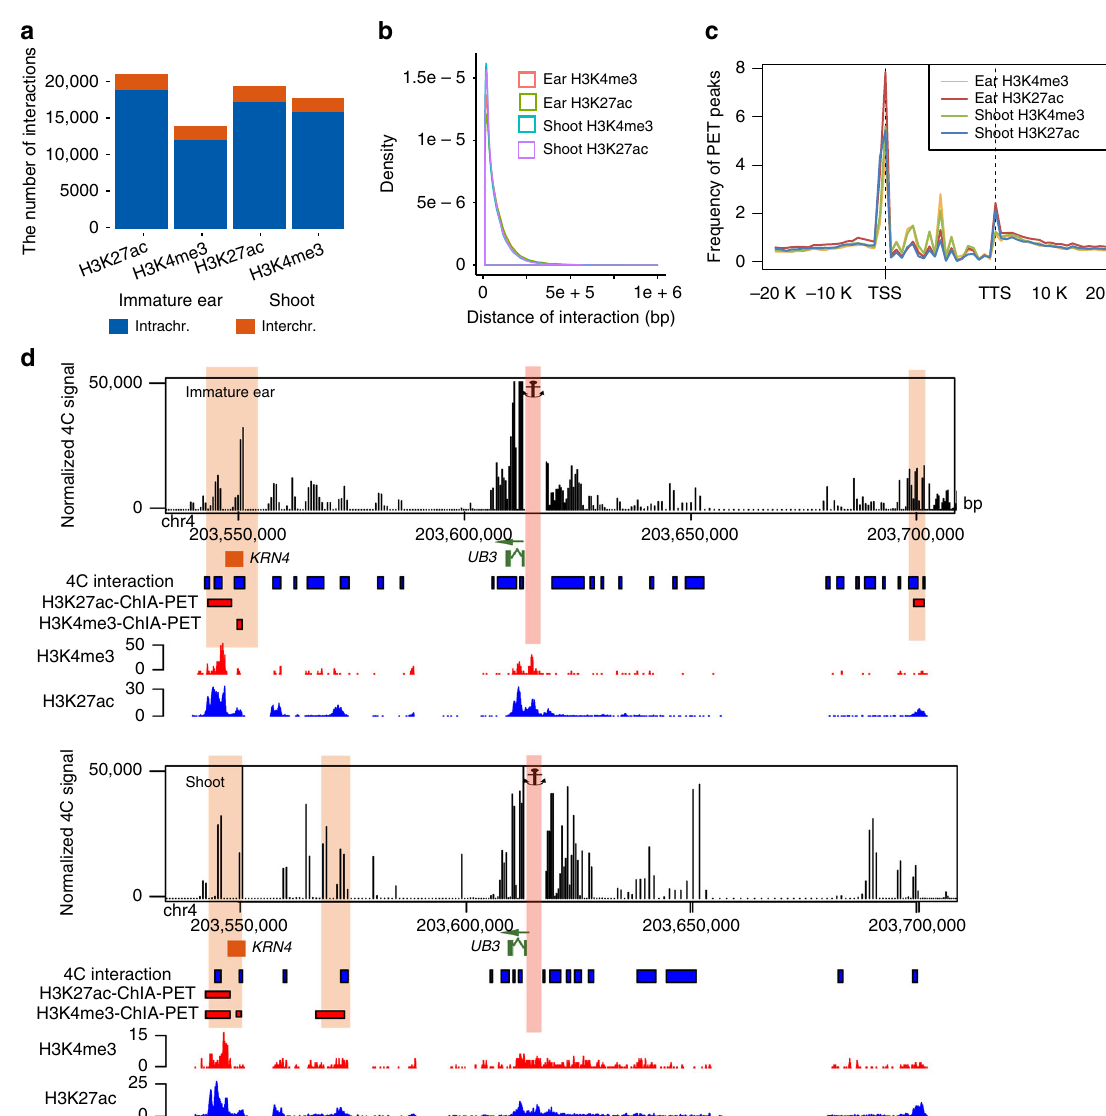
Fig. 1 Identi fi cation of chromatin interactions in immature ear and shoot. a The number of intra-chromosomal interactions (intrachr.) and inter- chromosomal interactions (interchr.) identi fi ed in H3K27ac-mediated and H3K4me3-mediate chromatin interaction analysis by paired-end tag sequencing (ChIA-PET) in immature ear and shoot. b The density distribution of chromatin interactions along the distance in H3K27ac-mediated and H3K4me3- mediate ChIA-PET in immature ear and shoot. c The pro fi le of PET peaks around gene body of H3K27ac-mediated and H3K4me3-mediate ChIA-PET in immature ear and shoot. d 4C validation for the promoter of UB3 as viewpoint in immature ear and shoot. The blue rectangles indicate the regions interacting with viewpoints in 4C experiments. The red rectangles indicate the regions interacting with viewpoints in ChIA-PET datasets. The orange rectangle represents the previously reported regulatory region ( KRN4 ) of UB3 . Source Data of Fig. 1d are provided as a Source Data fi